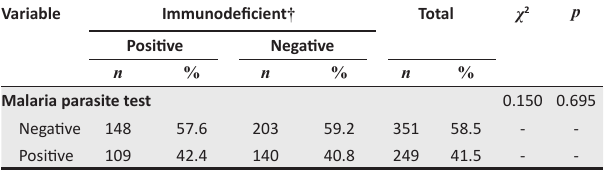
TABLE 3: Prevalence of malaria parasitaemia across immunodeficiency status of all participants in Abuja, Nigeria in 2012–2013. Variable Immunodeficient †